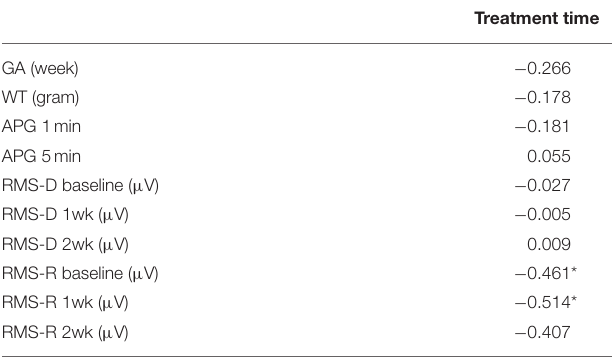
TABLE 3 | Correlation analysis among the clinical variables and duration of treatment ( n =